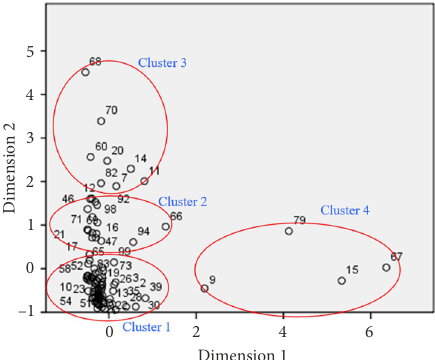
Figure 3. Bi-space scatter plot of companies